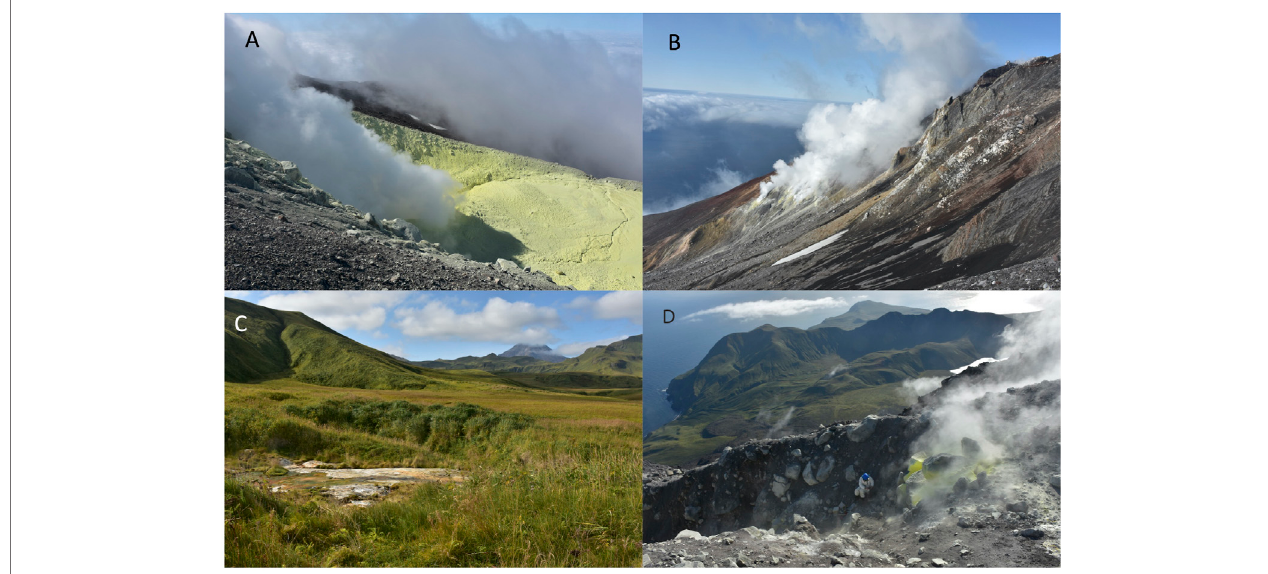
FIGURE2| Examples ofdegassingfeaturesintheWesternAleutians. A: Fumarole atthe fl ankofKiskaVolcano withnativesulfurdeposits. Thefumaroleseenhere isabout 10 m indiameterand theplume isabout 100 m tall. B: Fumaroles (100 – 270 ° C)at thesummitofGareloivolcano.The fumarole fi eld isabout 100 mwide. C: Hot spring (62 ° C) on the fl anks of Tanaga volcano; D: Fumaroles (boiling temperature) at summit of Kanaga Volcano.